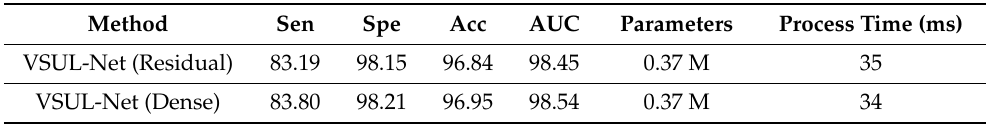
Table 5. Ablation study results for proposed VSUL-Net. The processing time is measured in millisec- onds (ms) for an image with size 650 × 650 pixels. Method Sen Spe Acc AUC Parameters Process Time (ms) VSUL-Net (Residual) 83.19 VSUL-Net (Dense)